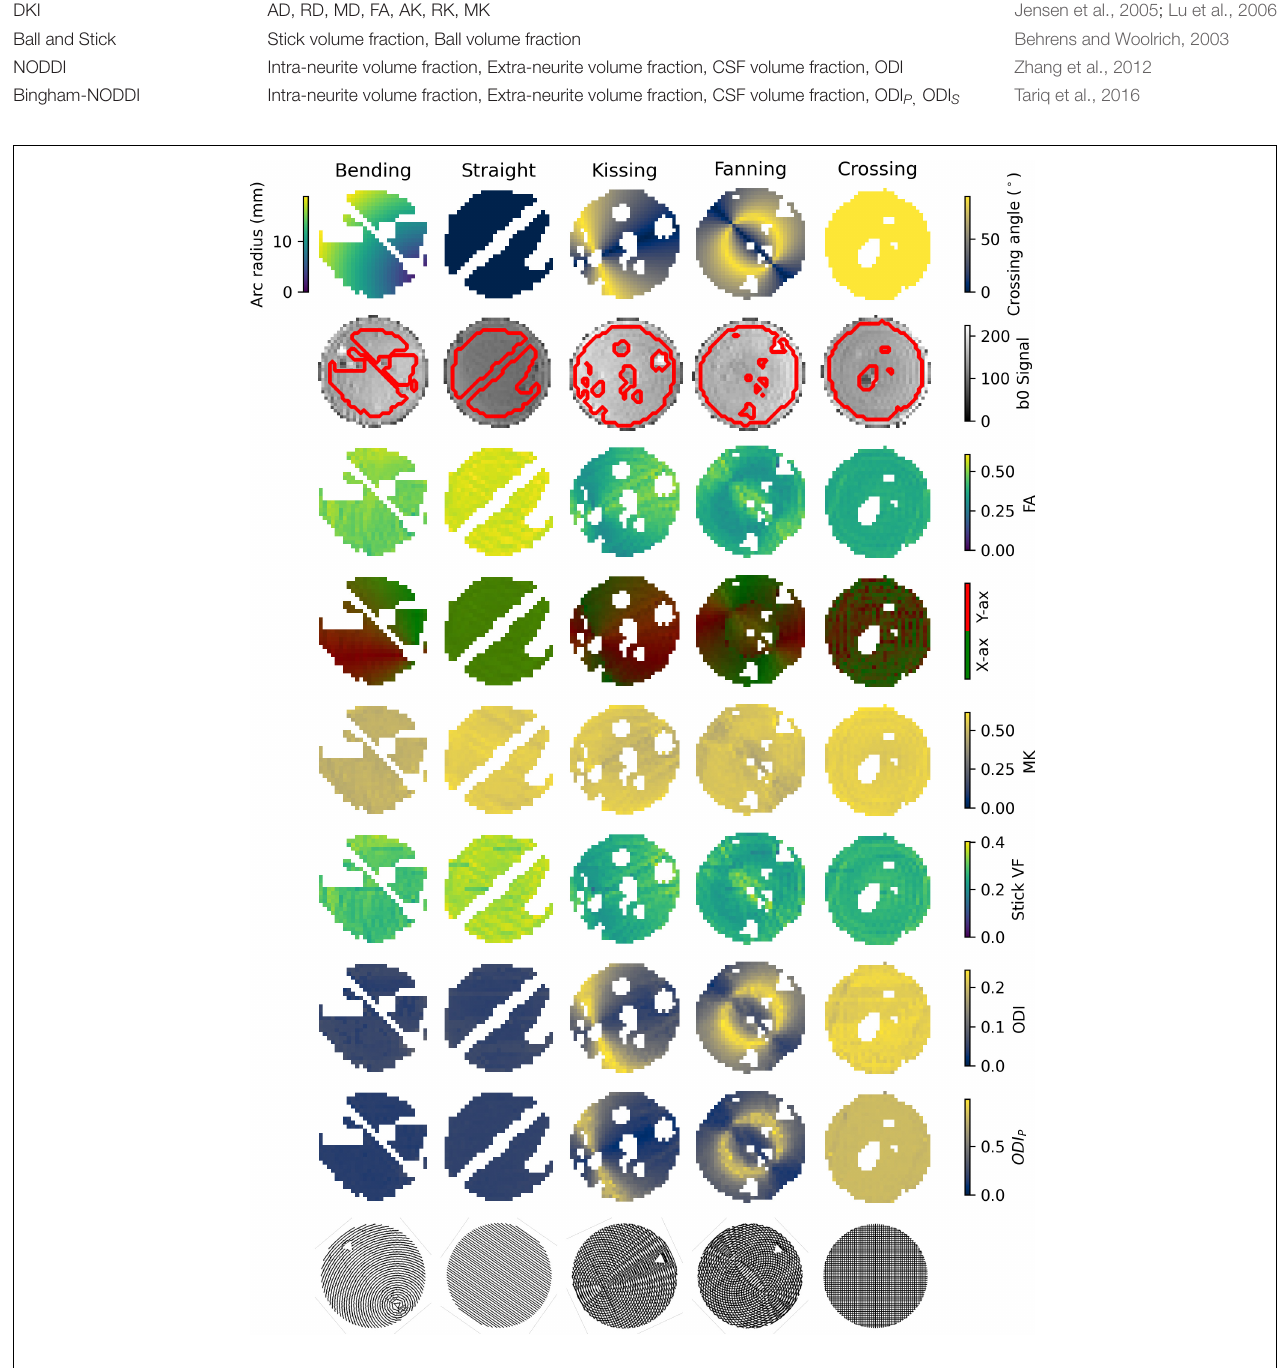
FIGURE 3 | Parameter maps of each phantom. Gaps in the images correspond to air bubbles and water-filled fiducials that were excluded with a manually drawn mask. The lines of masked out voxels in the bending and straight phantoms correspond to regions in which printer error deposed an unintended line of material between layers. Top row: Ground truth geometry metrics (Arc radius in the bending phantom, crossing angle in the others). Second row: b0 images with a contour of the mask superimposed. Third row: FA. Fourth row: Direction colour-encoded FA. Fifth row: MK. Sixth row: Stick volume fraction. Seventh row: ODI. Eighth row: ODI P . Ninth row: Phantom schematics, manually rotated to align with the scan images.